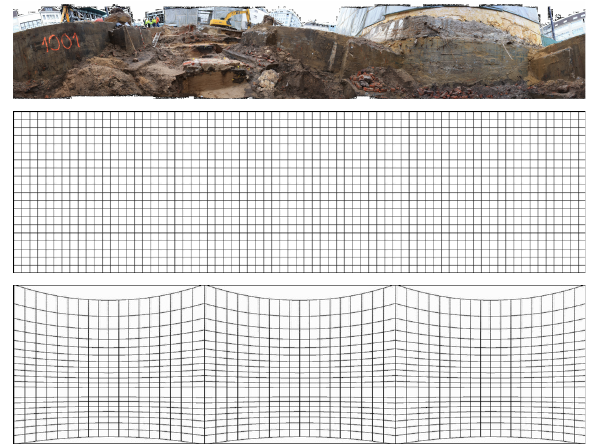
Figure 6: Top: Panorama image of an excavation site. Middle: Panorama image in eqirectangular prjection. Bottom: Panorama image composed of 3 Pannini projections.